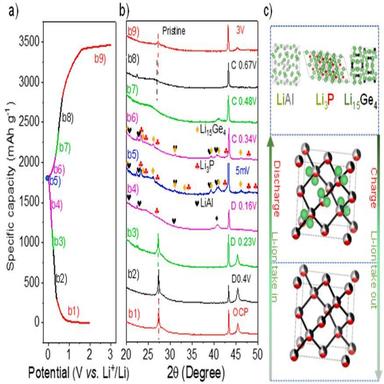
Characterization of Li-ion storage mechanism of AlGeP anode: (a) initial galvanostatic discharge–charge curves for ex-situ characterization at current rate of 100 mA g−1, (b) ex-situ XRD patterns corresponding to indicators marked in (a), and (c) schematic of overall Li-ion storage process.